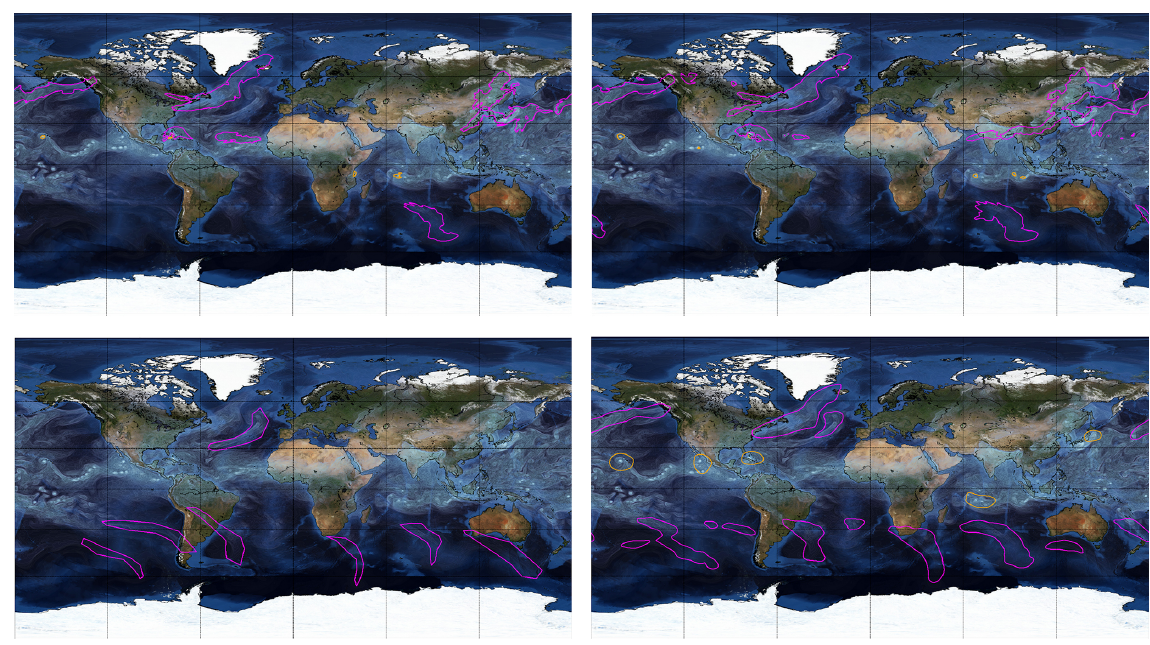
Figure 4. Comparison of labels from TECA (top left), model predictions trained on TECA (top right), the ClimateNet dataset (bottom left), and model predictions trained on ClimateNet (bottom right). The “bluemarble” map in the background included via Matplotlib’s Basemap library is © NASA.